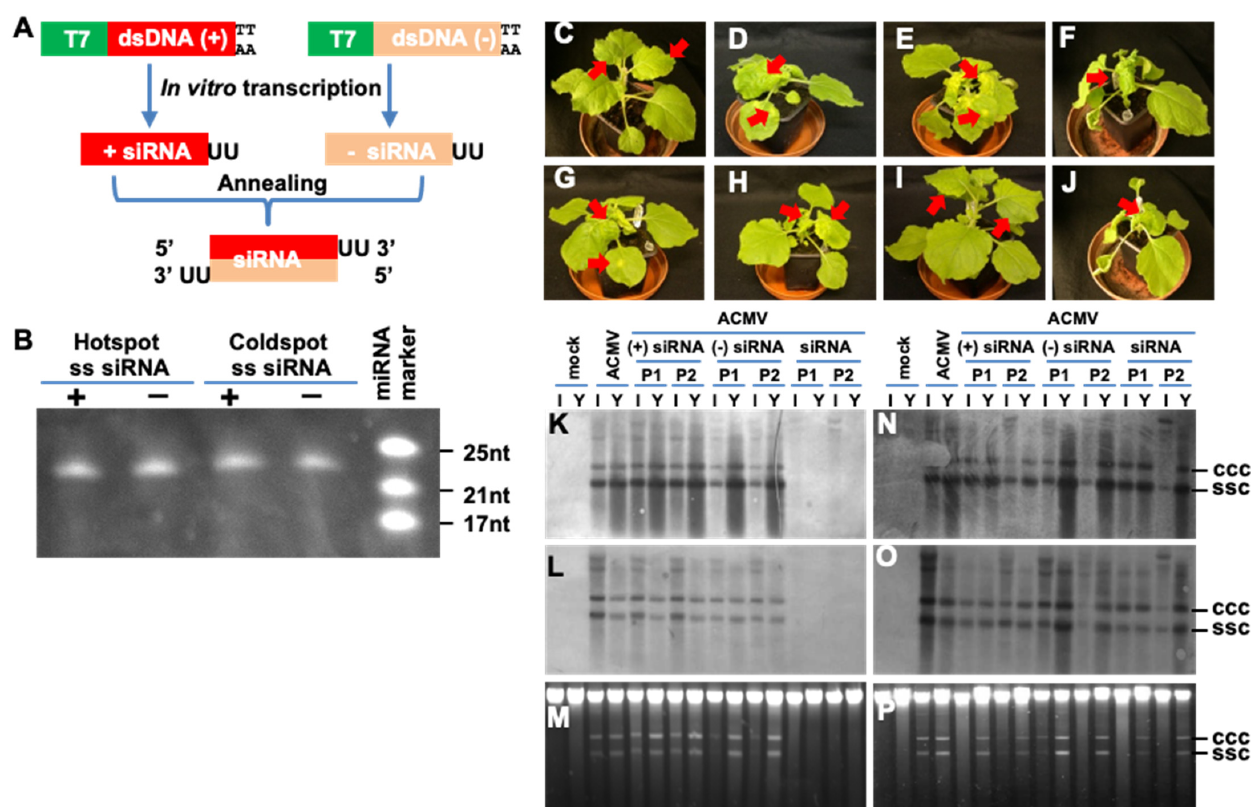
Figure 3. Hotspot siRNA inhibits ACMV infection. ( A ) Production of siRNA. Experimental strategy for in vitro synthesis of siRNA is outlined. Sense (+) and antisense ( − ) strand of siRNA with 3 ′ -UU overhang were produced by in vitro transcription using T7 promoter-controlled dsDNA (+) and ( − ) templates. The (+) and ( − ) single-stranded (ss) siRNAs were mixed as 1:1 ratio and annealed to form siRNA. ( B ) Denaturing PAGE analyses of hotspot and coldspot siRNA. The positions and sizes of the miRNA markers are indicated. The transcribed siRNAs generated by in vitro transcription were treated with DNase, purified with Phenol/Chloroform extraction, and quantified before being checked on 15%PAGE/8M Urea gel electrophoresis. The sizes of these sRNAs are the same as predicted. ( C – J ) Impact of hotspot siRNA on ACMV infection. N. benthamiana plants were mock-inoculated ( C ), inoculated with ACMV (500 ng pCLV1.3A and 500 ng pCLV2B) ( D ) alone or co-inoculated with ACMV and 20 µ g sense (+) strand of hotspot ( E ) or non-hotspot ( F ), antisense ( − ) strand of hotspot ( G ) or non-hotspot ( H ), or double-stranded (ds) hotspot ( I ) or non- hotspot ( J ) siRNA. Plants were photographed at 14 dpi. Typical ACMV symptoms including local chlorotic/yellow lesions, chlorosis and curling on systemic young leaves are indicated by arrows. Systemic healthy leaves in mock ( C ) and hotspot siRNA-protected ( I ) plants are also indicated. Hotspot ds-siRNA prevented plants from ACMV infection and plants remained symptomless at 3 months post co-inoculation. ( K – P ) Impact of hotspot siRNA on ACMV DNA replication. Total DNAs were extracted from systemic young (Y) and inoculated (I) leaf tissues of N. benthaniana plants with mock inoculation and of plants inoculated with ACMV alone, or together with sense (+), antisense ( − ), or siRNA corresponding to hotspot ( K – M ) or non-hotspot ( N – P ) vsiRNAs at 14 days post-inoculation. Duplicate plants (P1 and P2) were sampled for detection. Viral DNA was detected by probes specific to DNA-A ( K , N ) or DNA-B ( L , O ). GelRed staining shows equal loading of total DNA ( M , P ). The positions of single-stranded circular (ssc) and covalently closed circular (ccc) DNA are